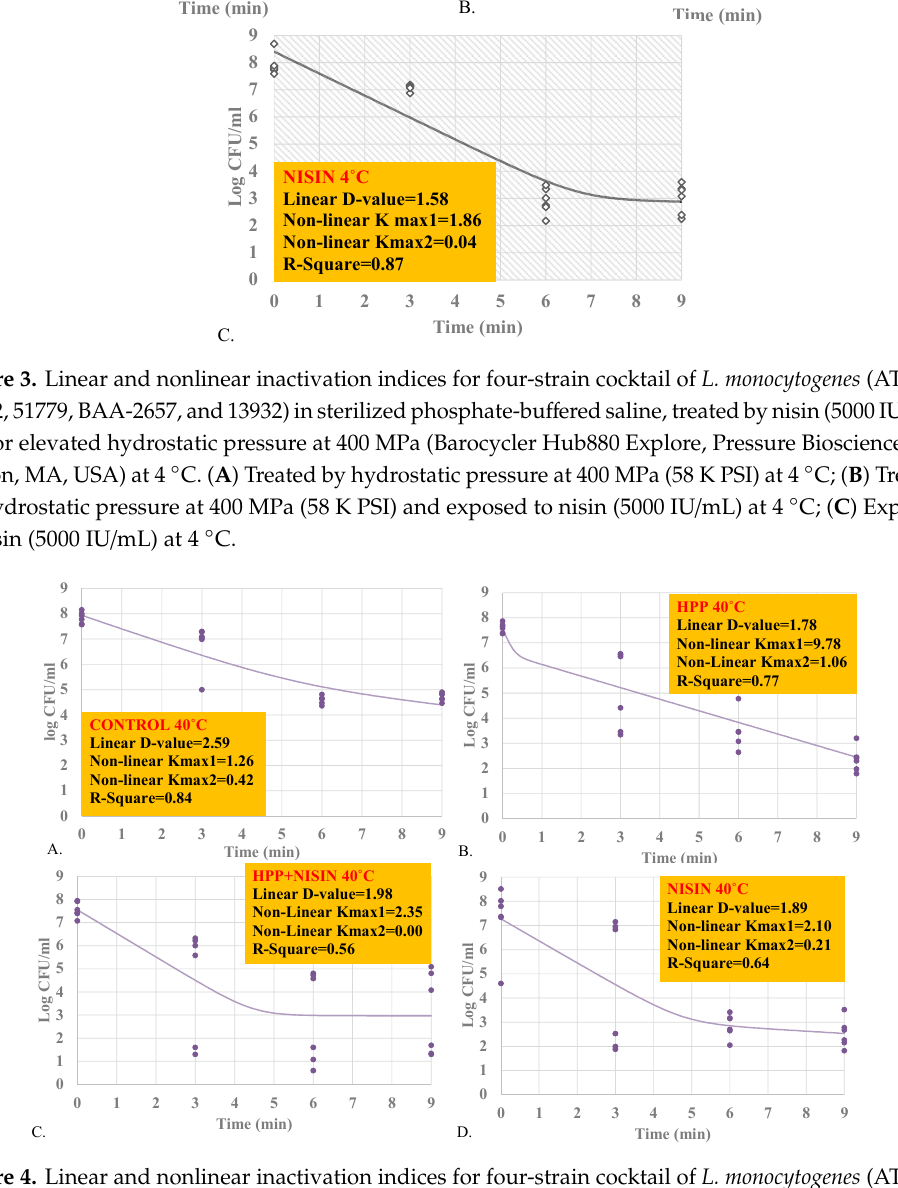
Figure 4. Linear and nonlinear inactivation indices for four-strain cocktail of L. monocytogenes (ATCC @ 51772, 51779, BAA-2657, and 13932) in sterilized phosphate-buffered saline, treated by nisin (5000 IU/mL) and/or elevated hydrostatic pressure at 400 MPa (Barocycler Hub880 Explore, Pressure Bioscience Inc., Easton, MA, USA) at 40 °C. ( A ) Treated by heat at 40 °C; ( B ) Treated by hydrostatic pressure at 400 MPa (58 K PSI) and at 40 °C; ( C ) Treated by hydrostatic pressure at 400 MPa (58 K PSI) and exposed to nisin (5000 IU/mL) at 40 °C; ( D ) Exposed to nisin (5000 IU/mL) at 40 °C.